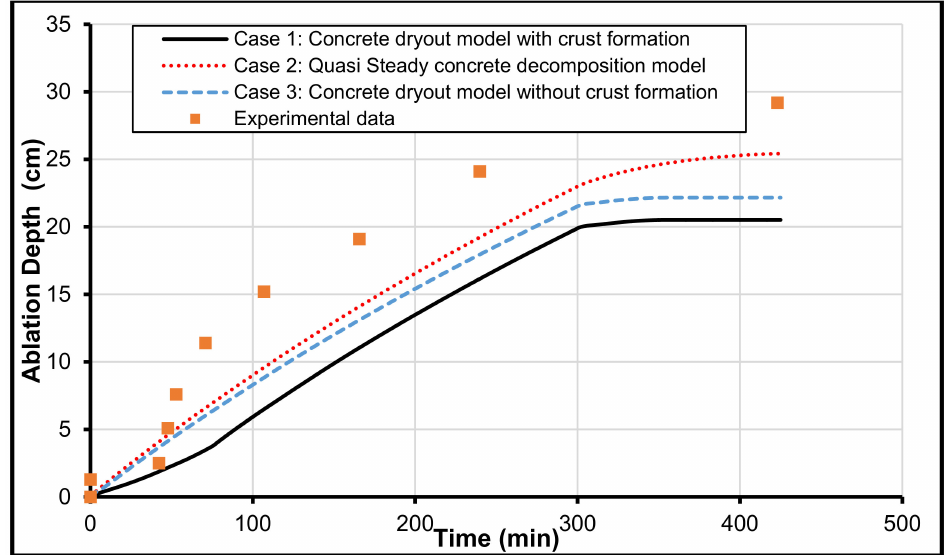
Figure 3. Comparison of CCI-2 experimental concrete axial ablation data with the developed model.